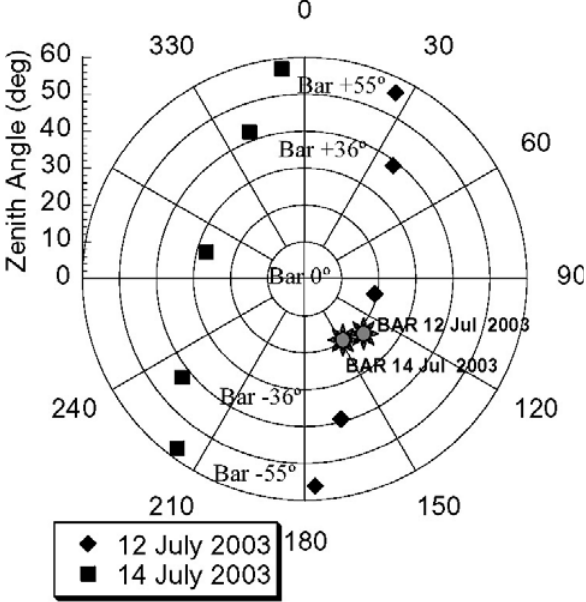
Figure 2. Acquisition geometries and illumination angles for the CHRIS/PROBA images acquired over Barrax on the 12th and the 14th of July